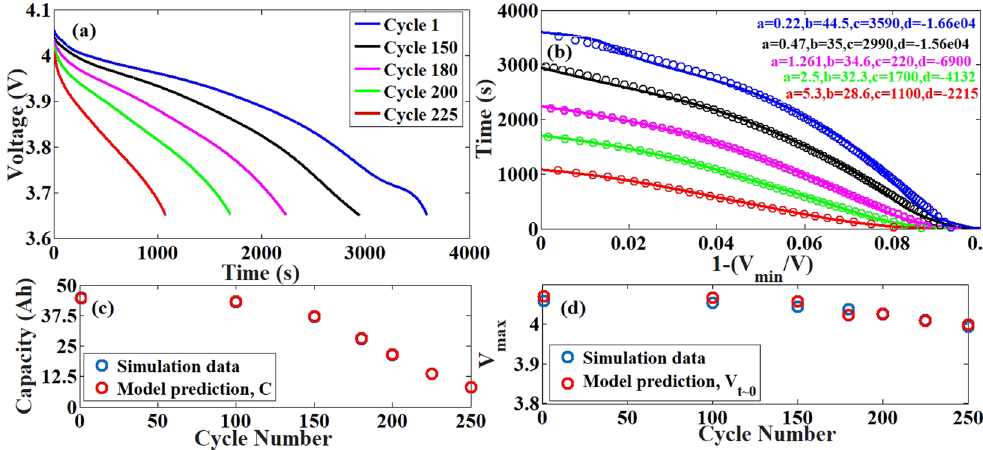
Figure 2. Comparison between simulation data and model prediction for the NG-LMO system with only LMO degradation. ( a ) The discharge profiles obtained from ECT simulations using the LMO dissolution model. ( b ) The reduced parameter representation of the discharge curves in the new system (bold lines) and the model prediction (circles) with the parameter values mentioned in the legend. ( c ) The comparison of the capacity loss (available capacity) over cycling obtained from the ECT simulations and the prediction from the model. The time taken for full discharge over a cycle is taken as a measure of the capacity. ( d ) The comparison of the resistance induced loss obtained from the simulations and the prediction from the model. The voltage at the start of discharge (V max ) is taken as a measure to predict the resistance induced loss. The maximum error between the predicted and actual data is < 0.4%.